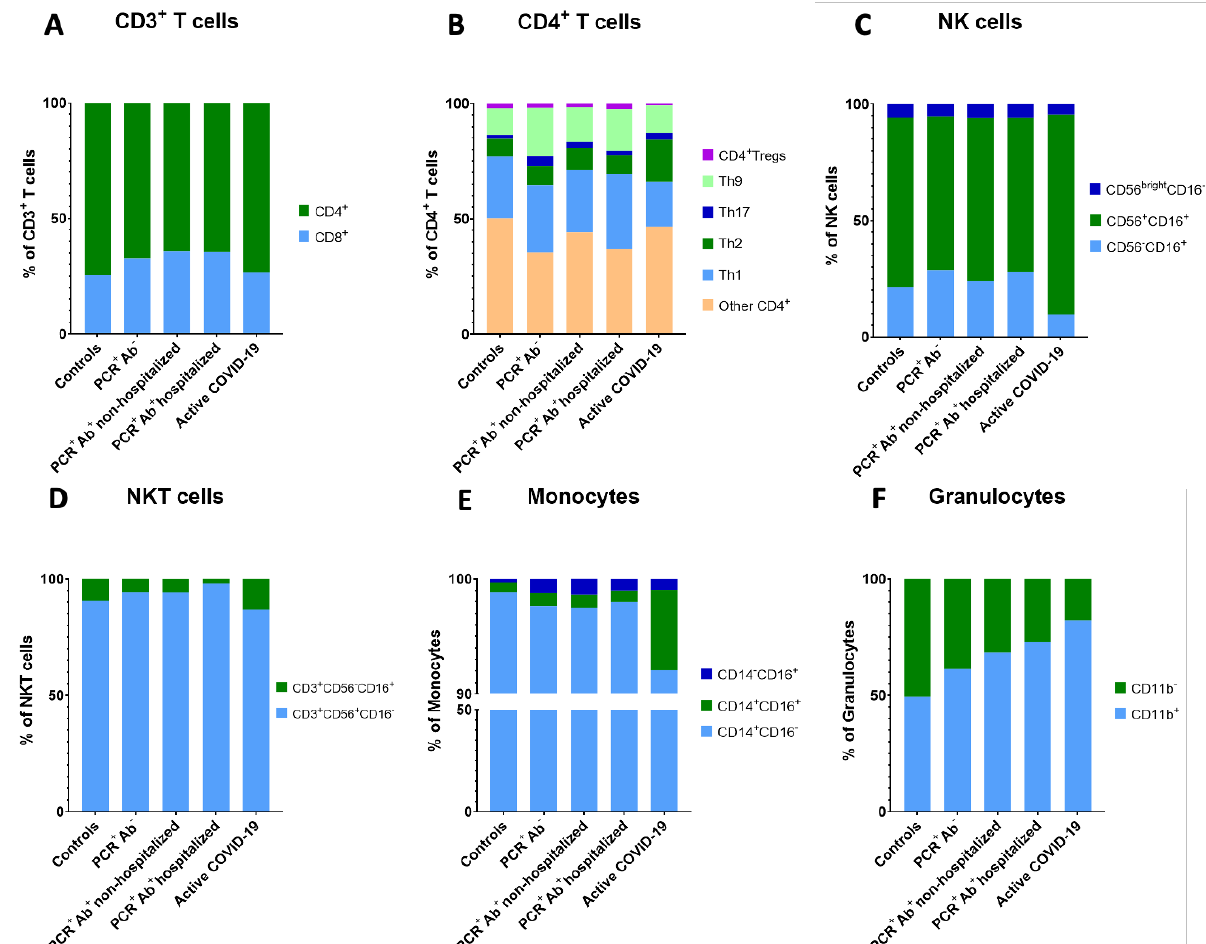
Figure 2. Distribution of ( A ) CD4 + and CD8 + subpopulations in CD3 + T cells, ( B ) Th1, Th2, Th9, Th17, and Treg subpopulations in CD4 + T cells, ( C ) immature (CD56 bright CD16 − ), mature (CD56 + CD16 + ), and memory-like (CD56-CD16 + ) subpopulations in NK cells, ( D ) CD3 + CD56 + CD16 − and CD3 + CD56 − CD16 + subpopulations in NKT cells, ( E ) classical (CD14 + CD16 − ), intermediate (CD14 + CD16 + ), and non-classical (CD14-CD16 + ) subpopulations in monocytes, and ( F ) CD11b+ and CD11b − subpopulations in granulocytes in controls, the three groups of recovered CP donors and active COVID-19